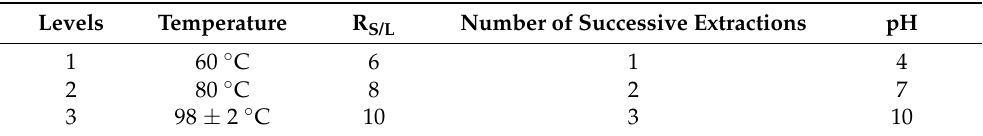
Table 7. Orthogonal design table of extraction condition.